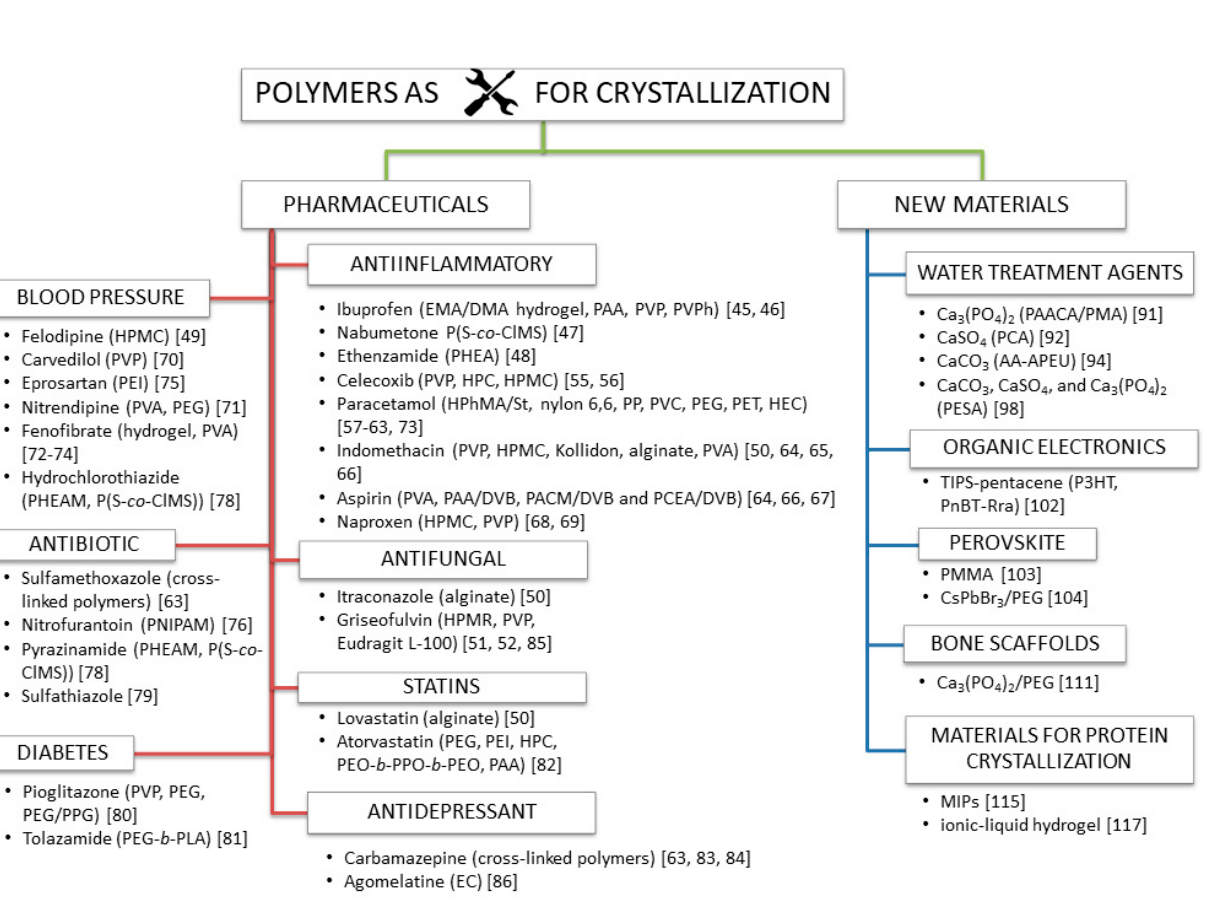
Figure 2. Utilization of polymers in drug amelioration and new material preparation.